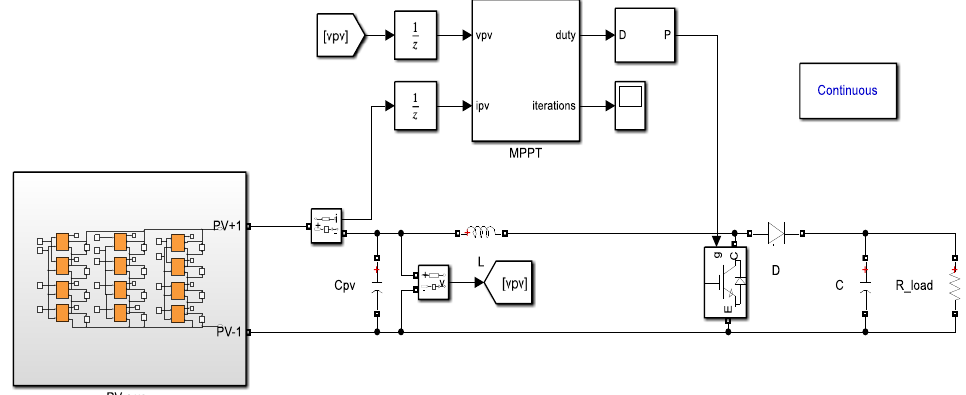
Figure 1. MATLAB Simulink Photovoltaic system model.